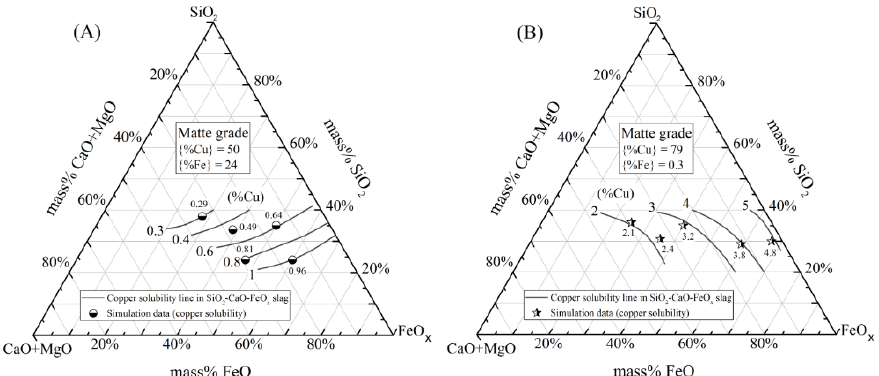
Figure 8. Comparison of the CaO-MgO-SiO 2 -FeO X phase diagram with previously reported data [25] and simulation results for Cu solubility as a function of initial Cu content in the matte at 1573 K. The matte compositions in Figures ( A ) and ( B ) are 50 mass% Cu-24 mass% Fe and 79 mass% Cu-0.3 mass% Fe, respectively.